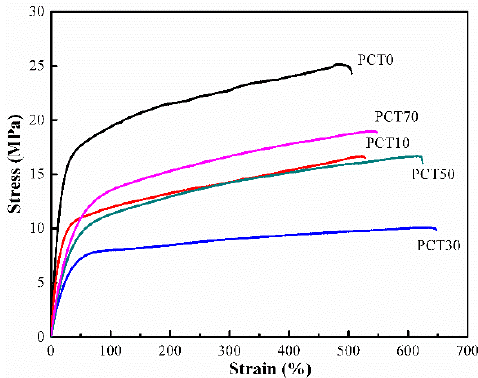
( d ) Figure 7. TGA and DTG thermograms of the (PBT-co-PCT)-b-PTMG copolymers at 20 °C min – 1 : ( a ) TGA in nitrogen atmosphere; ( b ) TGA in oxygen atmosphere; ( c ) DTG in nitrogen atmosphere; and ( d ) DTG in oxygen atmosphere. 3.6. Mechanical Properties Figure 8 shows the stress–strain curves of the (PBT-co-PCT)-b-PTMG copolymers. Each curve is the average of five specimens. They all exhibit a typical thermoplastic elastomer behavior: an elastic deformation with small elongations, followed by a decrease in the slope without an apparent yield